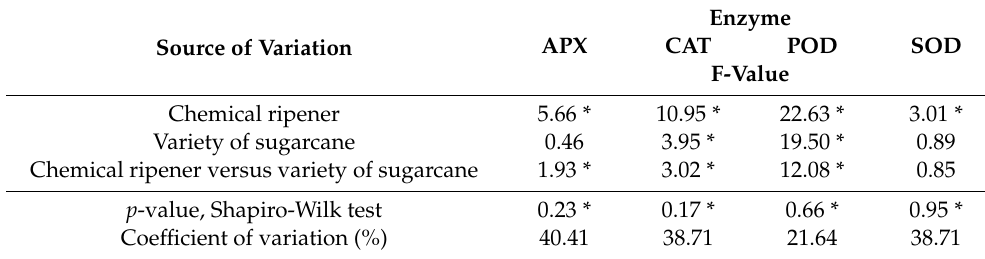
Table 3. Analysis of variance for the e ff ects of chemical ripening agents and varieties of sugarcane on the activity of antioxidant enzymes.